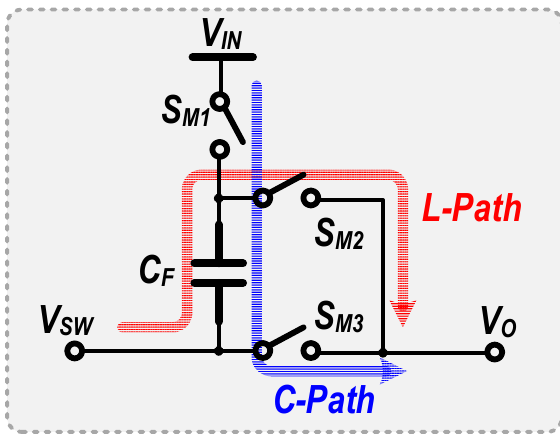
Figure 4. Energy transfer media with a flying capacitor.